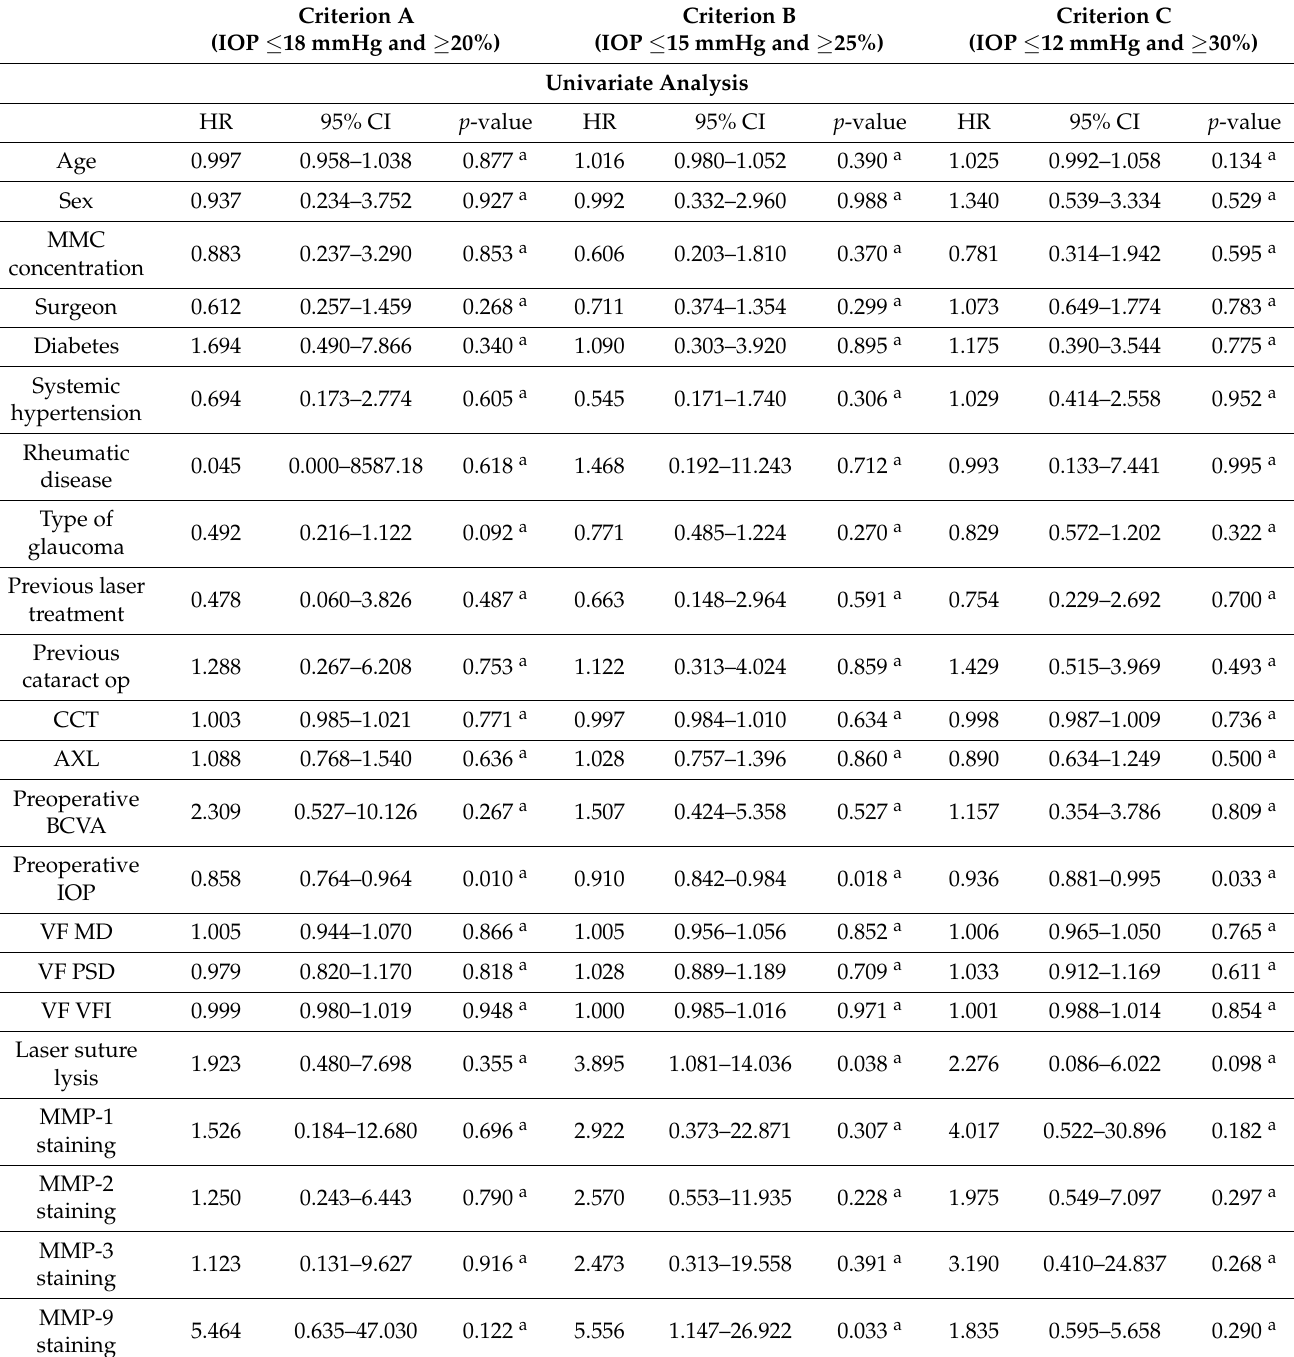
Table 3. Univariate and multivariate Cox’s proportional hazard model data for prediction of